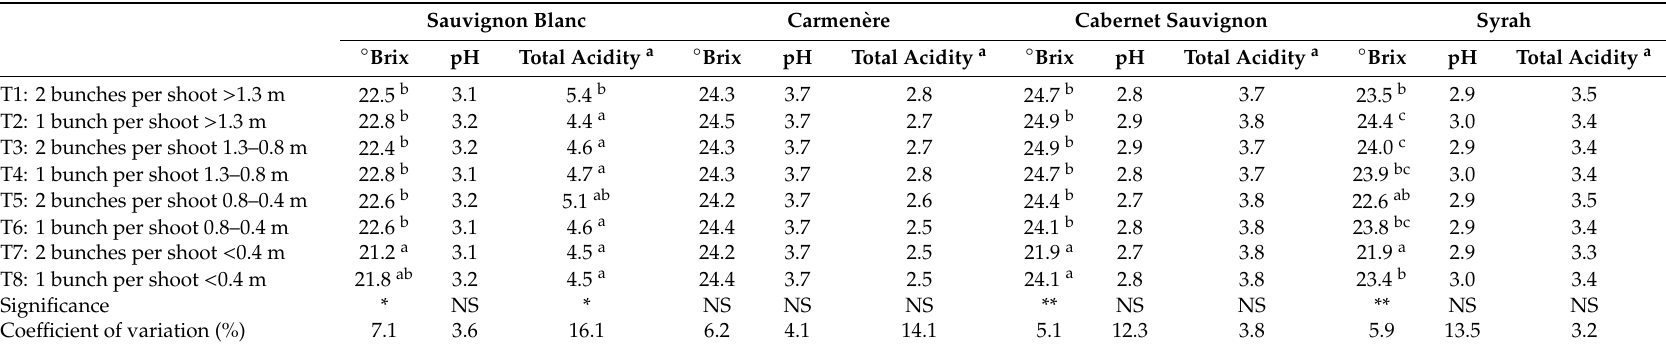
Table 3. E ff ects of the leaf-to-fruit ratios (cm 2 / g) on must enological parameters in cv. “Sauvignon blanc”, “Carmen è re”, “Cabernet Sauvignon”, and “Syrah”. Sauvignon Blanc Carmen è re Cabernet Sauvignon Syrah